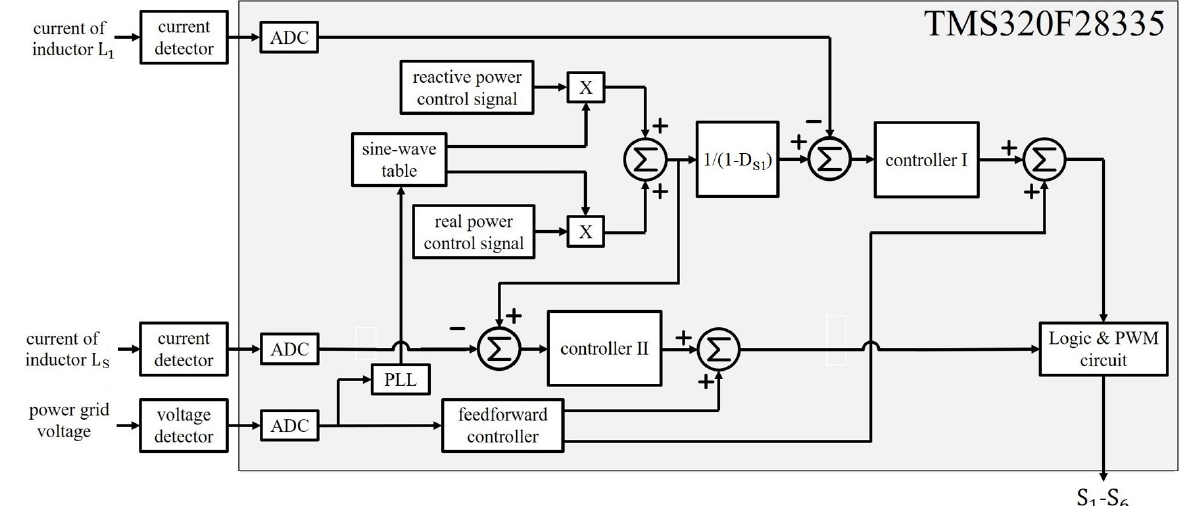
Figure 5. Control block of the BBI.